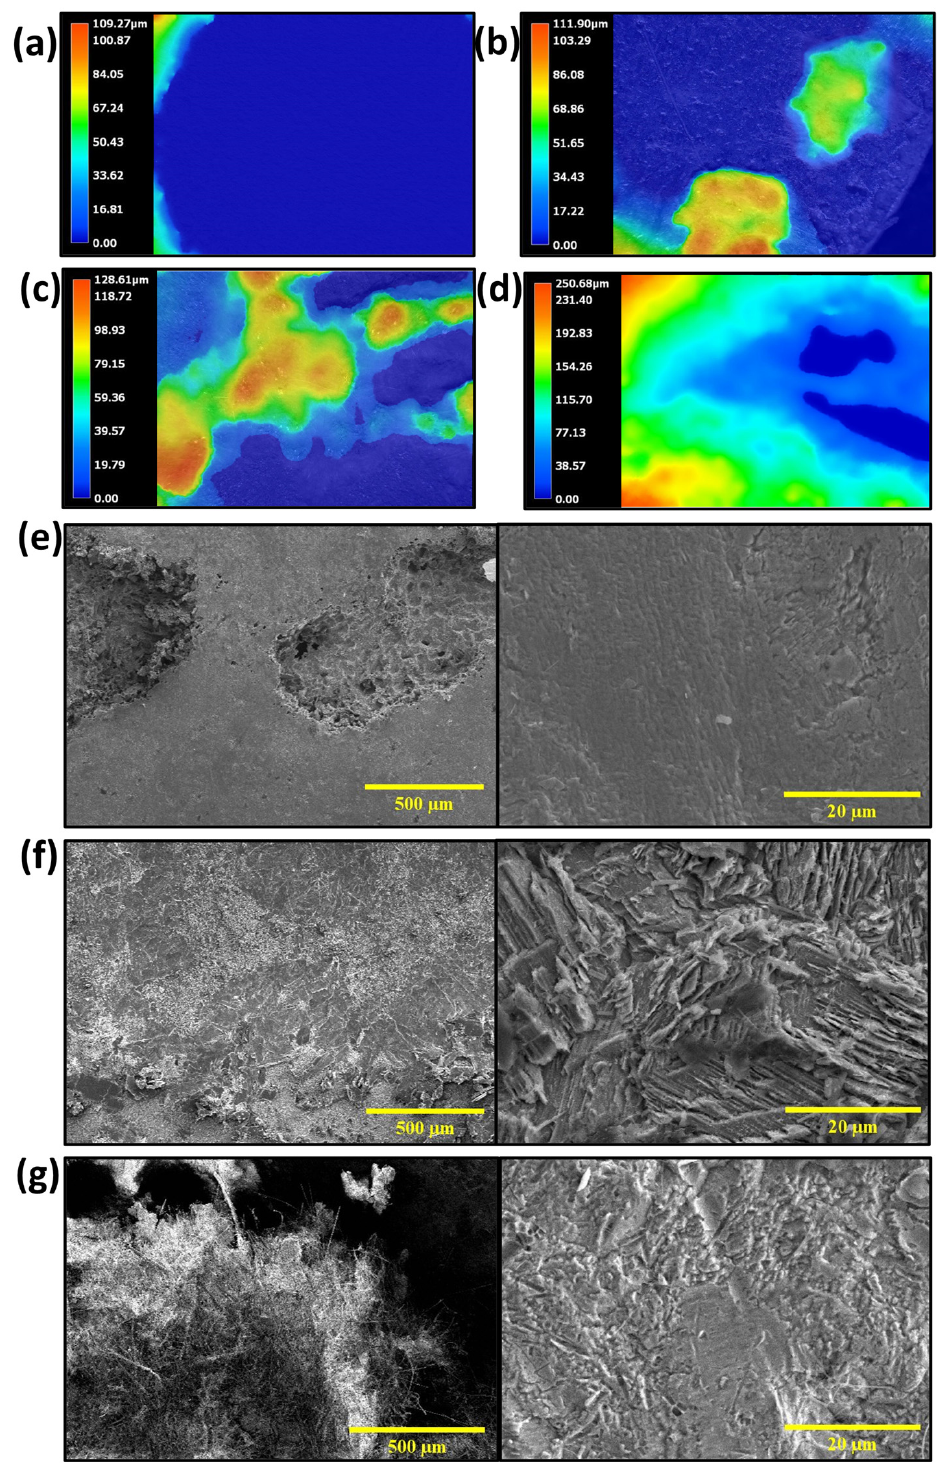
Figure 5. Optical microscope images and ex situ SEM images of electrodes from the various symmetric cells. Optical microscope images of ( a ) fresh Zn, ( b ) cycled bare Zn, ( c ) cycled Zn@BLM, and ( d ) cycled Zn@LMNP. SEM images of the anode-side electrode of the ( e ) bare Zn||Zn cell, ( f ) Zn@BLM||Zn@BLM cell, and ( g ) Zn@LMNP||Zn@LMNP cell after long-term cycling of the symmetric cells in Figure 4g.